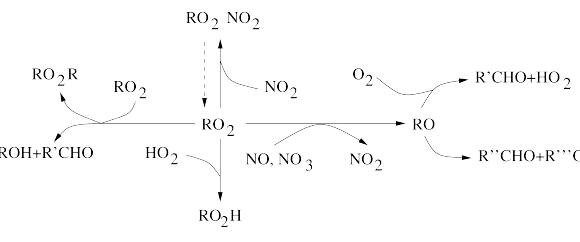
Fig. 12. Reaction pathways of the RO 2 radical in MELCHIOR 1.